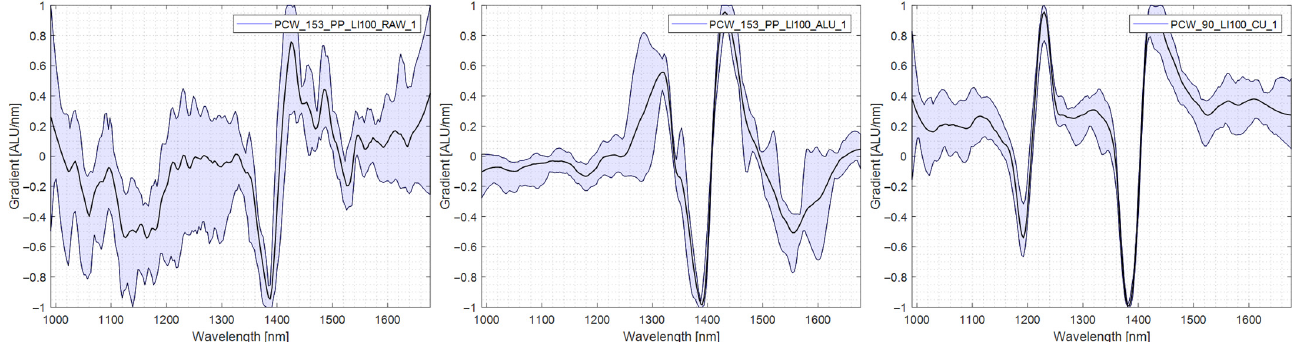
Figure 14. Comparison of PP spectra, left : no reflector, middle: aluminium reflector, right : copper reflector.